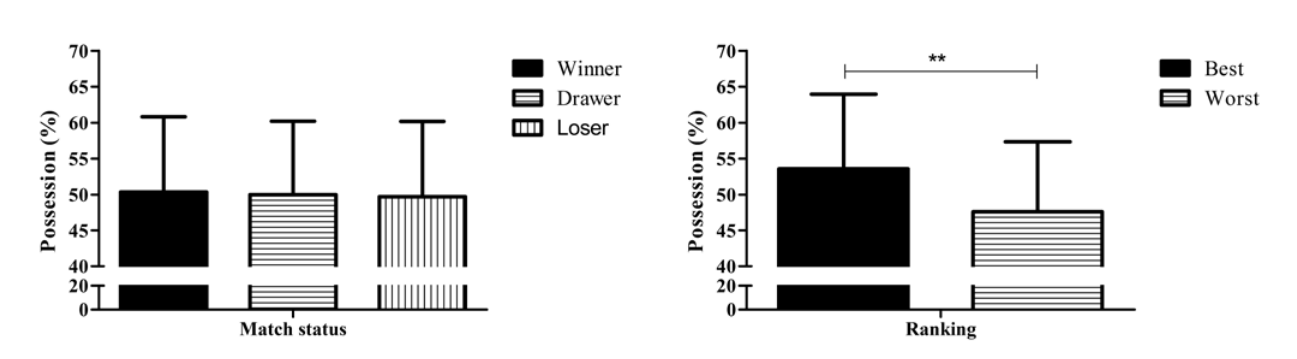
Figure 2. Influence of match status (A) and team ranking (B) on possession during the England Premier League season 2015/16. ** p < 0.001.